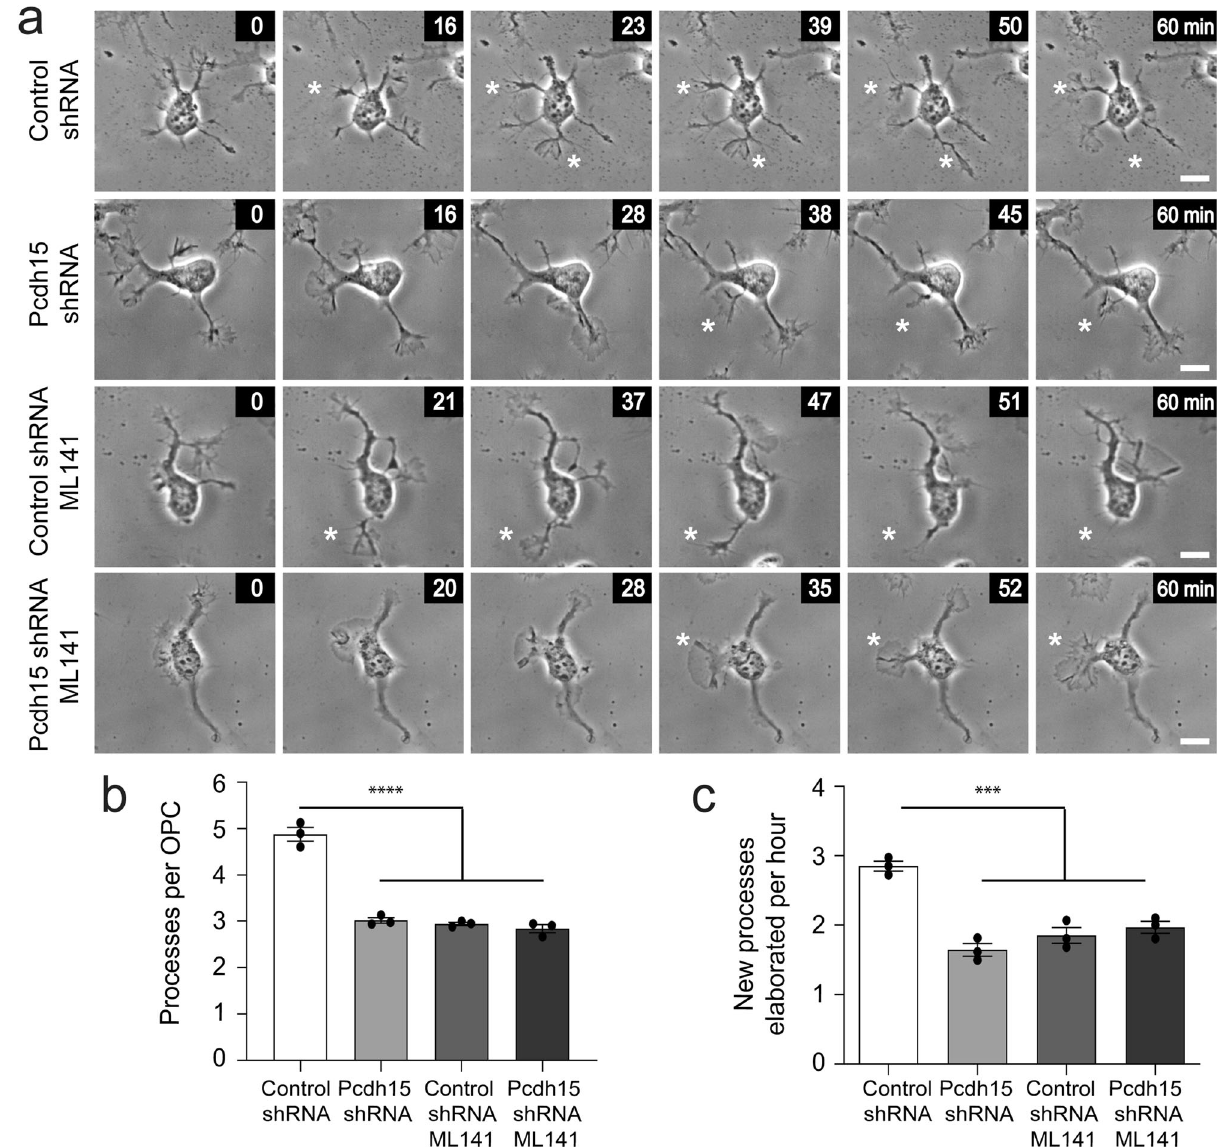
Fig. 10 Inhibiting Cdc42 activity phenocopies the effect of Pcdh15 knockdown on OPC process number and generation. a Image series extracted from time-lapse videos to show individual control and Pcdh15 knockdown OPCs treated with DMSO or ML141 (10 µ M), as they elaborate new processes over time. All images are time-stamped relative to the fi rst image in the depicted series (designated as 0 min). White asterisks indicate the new process. b The mean number of processes supported by control and Pcdh15 knockdown OPCs treated with DMSO or ML141 [mean ± SEM, n = 3 independent cultures, ≥ 76 OPCs analysed per condition; one-way ANOVA: F (3,8) = 108.4, **** p < 0.0001]. c The mean number of new processes that OPCs elaborated per hour in control and Pcdh15 knockdown cultures treated with DMSO or ML141 [mean ± SEM, n = 3 independent cultures and n ≥ 34 cells analysed per culture condition; two ‐ way ANOVA: shRNA treatment F (1,8) = 13.37, p = 0.0064; drug treatment F (1,8) = 35.06, p = 0.0004; interaction F (1,8) =